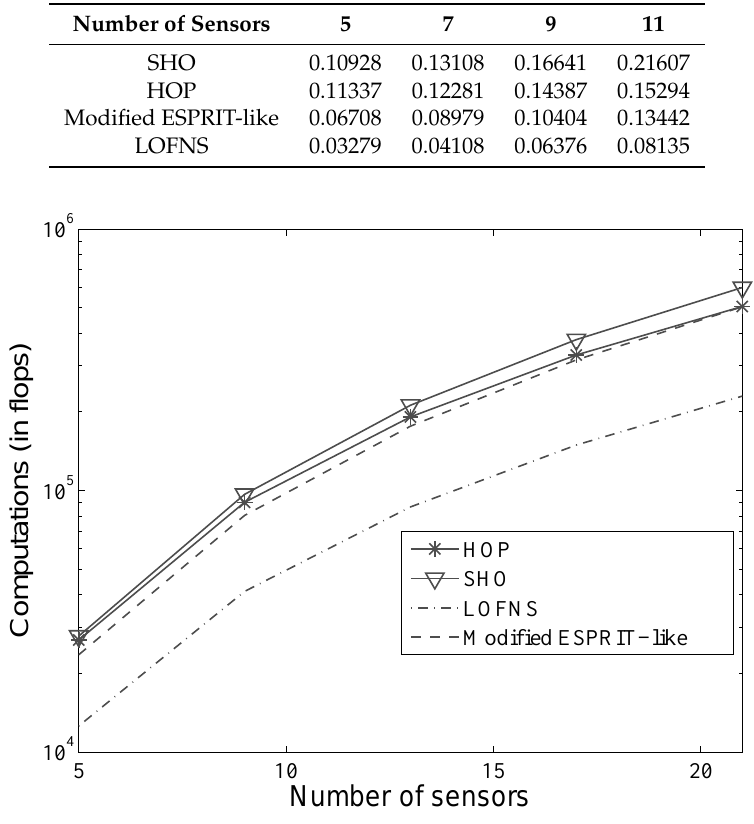
Table 2. Average processing time (seconds) for different methods.